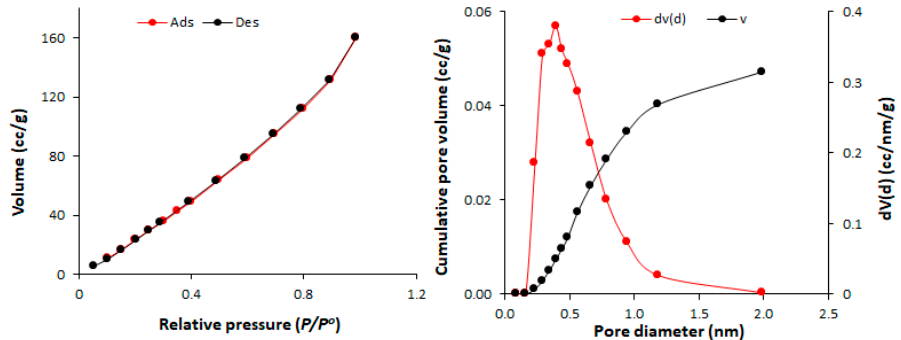
Figure 6. N 2 isotherms and pore size for 2 .